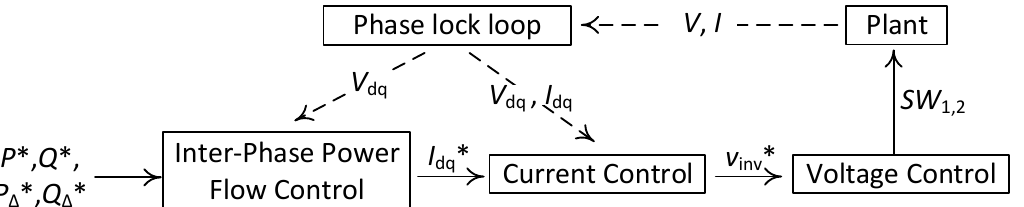
Figure 6. Interphase power flow control blocks of power electronic